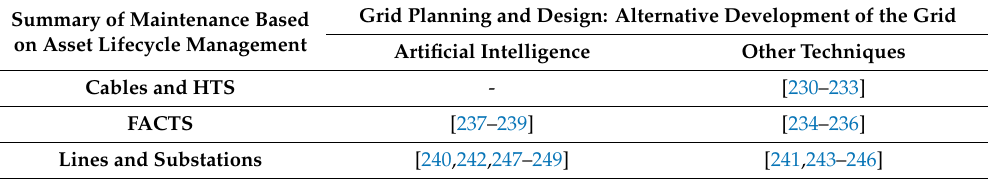
Table 10. Summary of Alternative Development of the